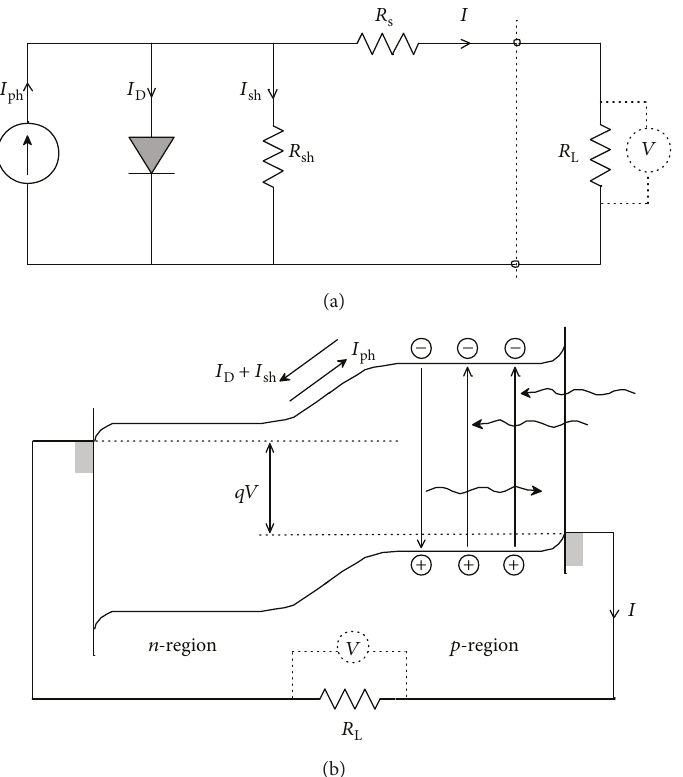
Figure 4: (a) Equivalent circuit model for an illuminated p - n junction solar cell connected to a load. (b) Energy band diagram of an illuminated solar cell corresponding to Figure 4(a).